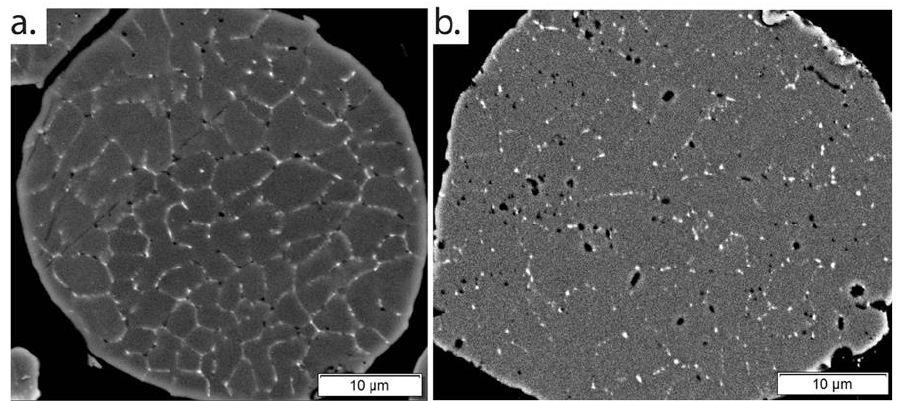
Figure 2. BSE images of cross sections of ( a ) the as-atomized powder and ( b ) the thermally treated powder.